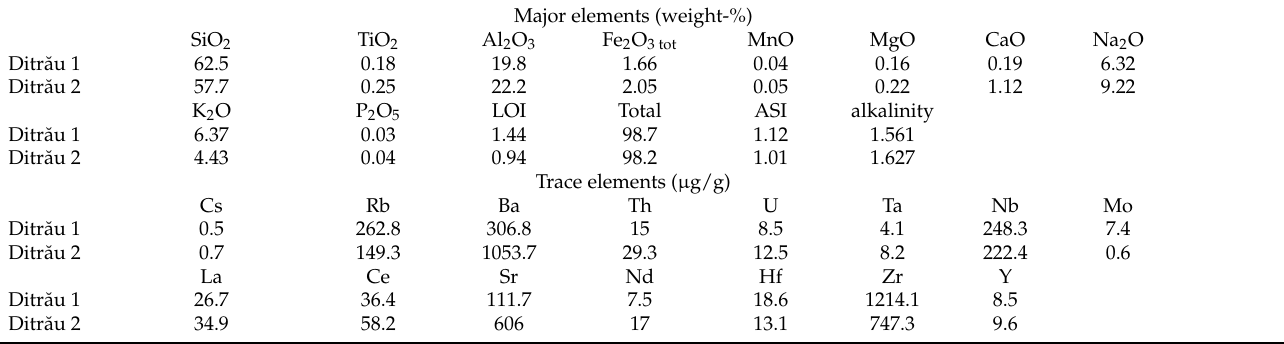
Table 1. Whole-rock geochemistry